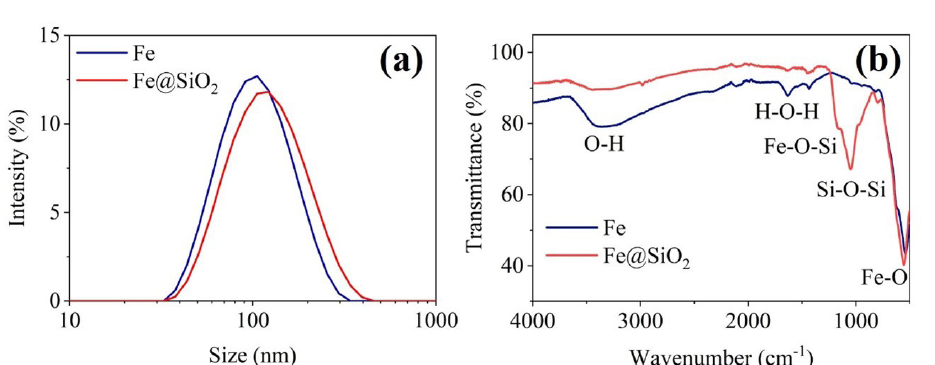
(red line) nanoparticles. 2